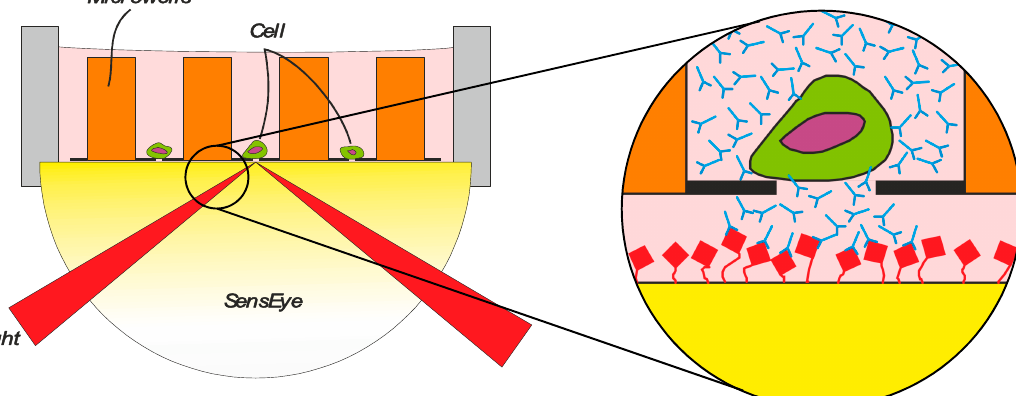
Figure 5. The principle of the McSPRinter. The microwell arrays with single cells is attached to a SPR sensor surface and immersed in cultivation medium. The product of the cells diffuses via the 1 µm membrane to the sensor surface. Reprinted from F. Abali et al. [44] Copyright 2017 with permission from Elsevier.